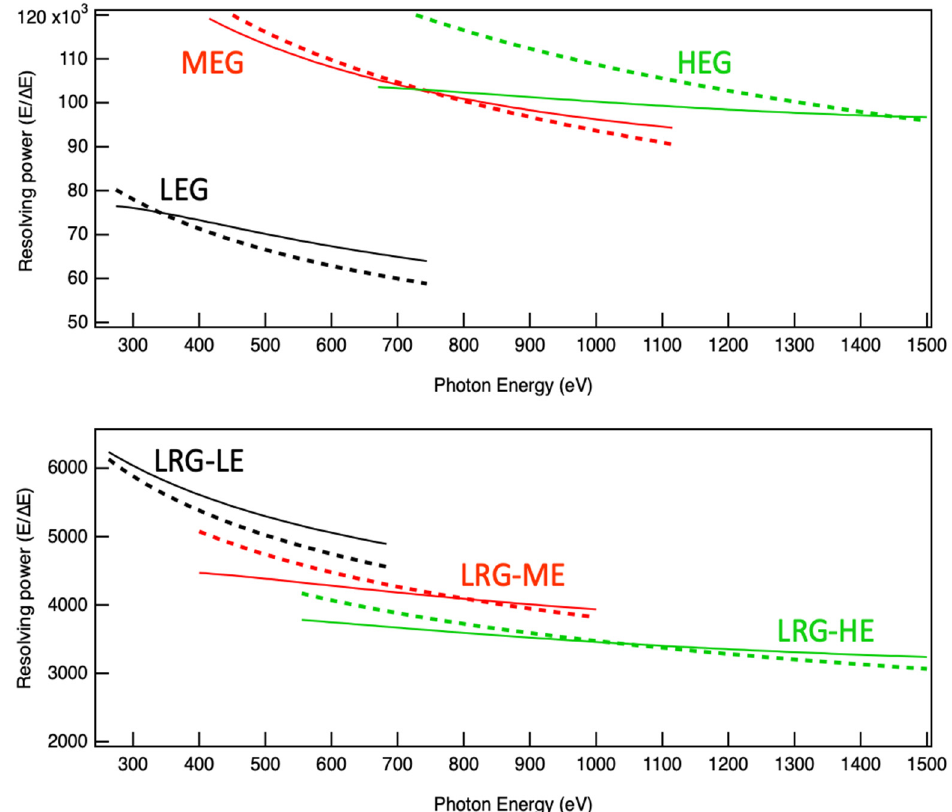
Figure 4. Contribution to the resolving power due to the image at the exit slit (full lines) and due to